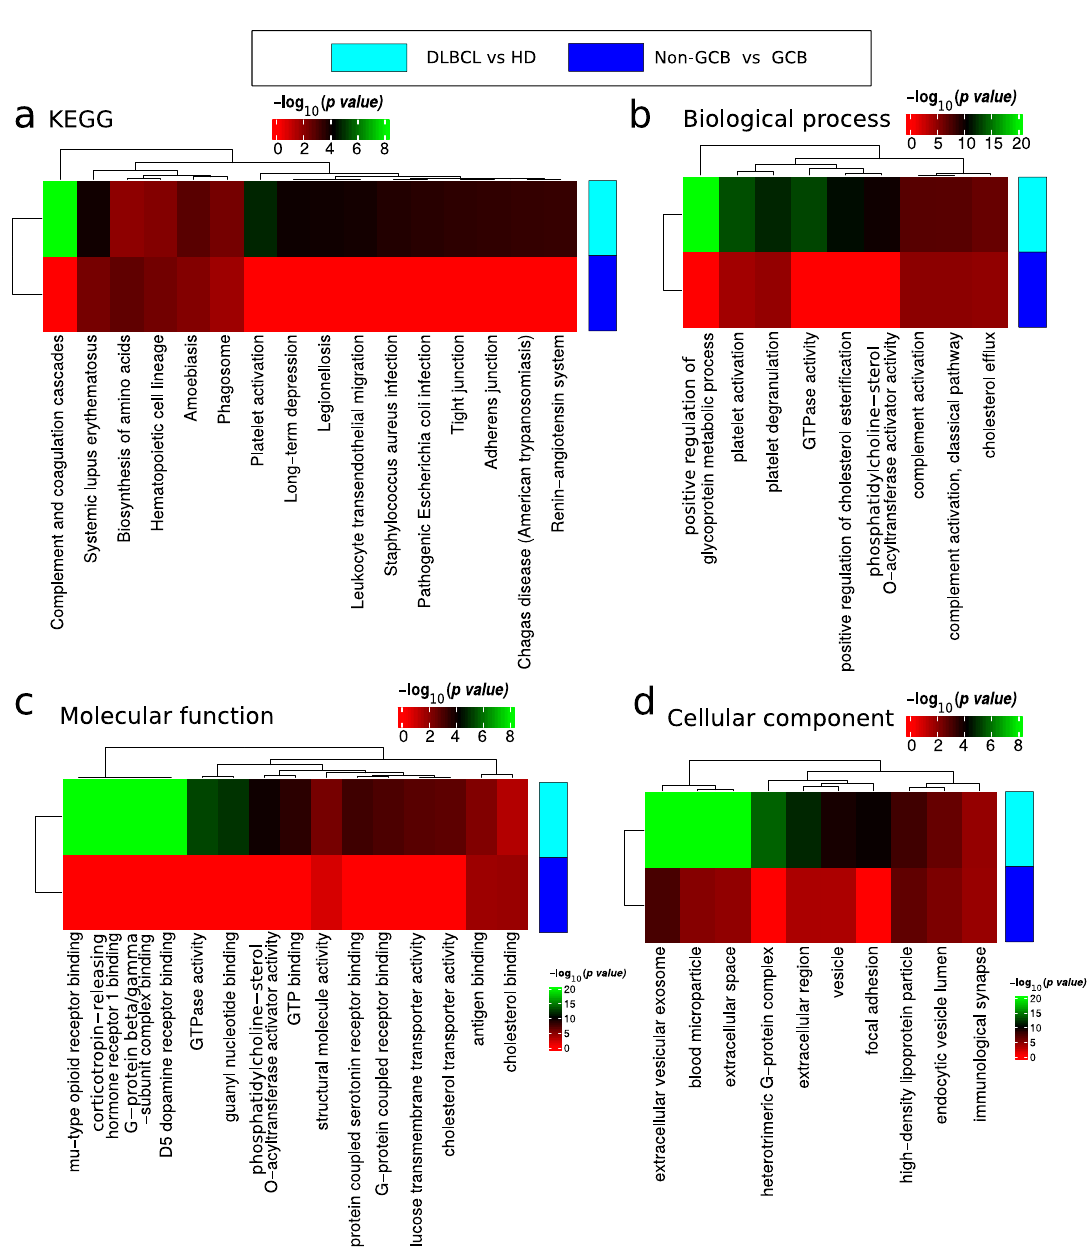
Figure 6. Functional enrichment analysis of differentially expressed proteins between DLBCL and HD and non-GCB and GCB. Analysis of ( a ) KEGG pathway, ( b ) biological process, ( c ) molecular function and ( d ) cellular component gene categories.